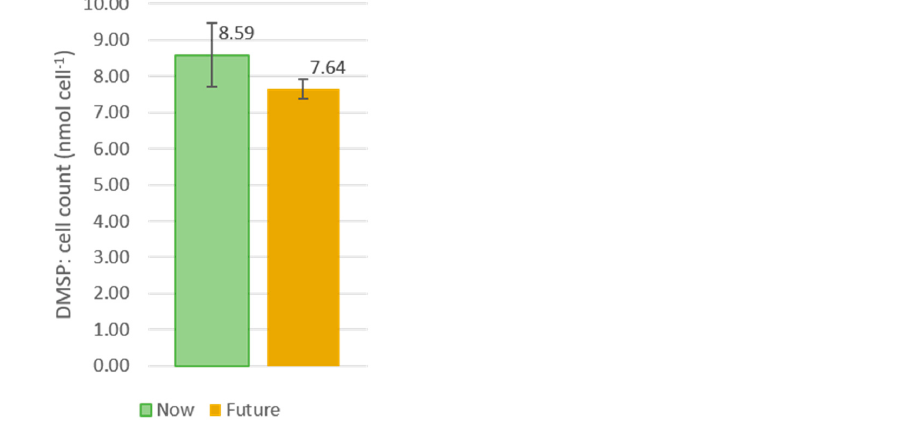
Figure 4. Averages of “Now” and “Future” DMSP content (in nmol cell − 1 ) with associated stand- ard deviations as error bars. deviations as error